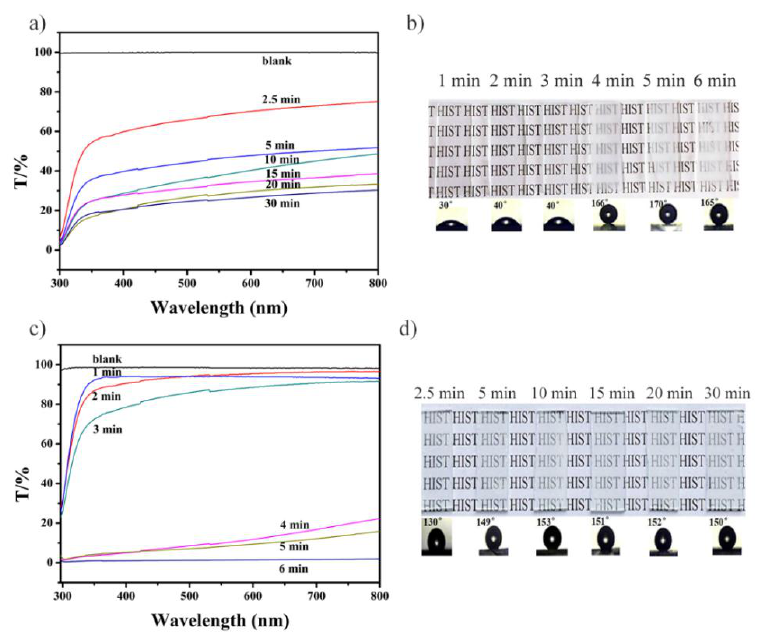
Figure 2. UV-Vis transmittance spectra ( a ), their relative transparency and their wetting property ( b ) for the microwave-irradiated coatings of mixture 5. UV-Vis transmittance spectra ( c ), their relative transparency and their wetting property ( d ) for the UV-irradiated coatings of mixture 5.